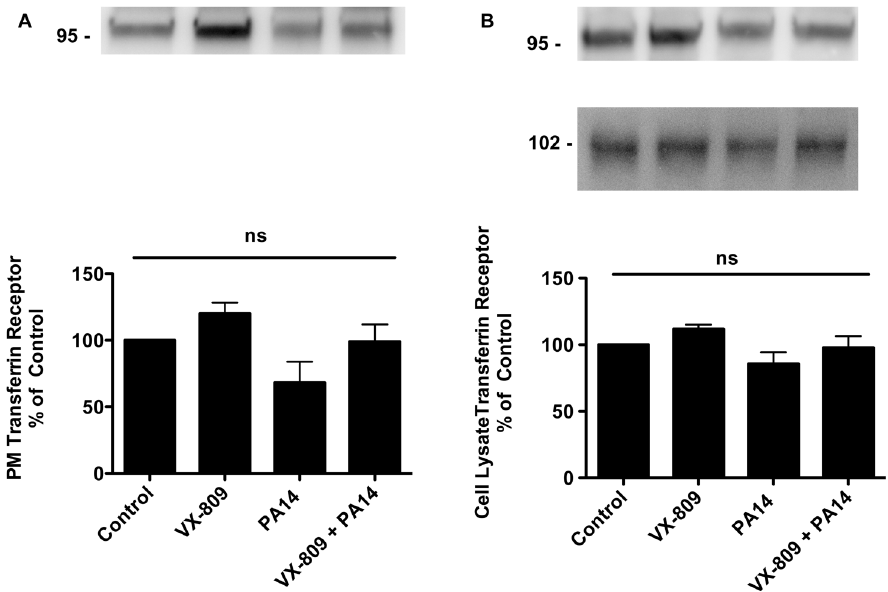
Fig 7. Analysis of plasma membrane transferrin receptor in the presence of VX-809 alone and in combination with P . aeruginosa . (A) Representative western blot of apical plasma membrane transferrin receptor (TfR) in CFBE cells treated with vehicle (Control), VX-809 (3 μ M), PA14 alone, or VX-809 (3 μ M) + PA14. ns, not significantly different. N = 3/treatment. (B) Top: Representative western blot of cell lysate TfR in CFBE cells treated with vehicle (Control), VX-809 (3 μ M), PA14 alone, or VX-809 (3 μ M) + PA14. Bottom: Representative western blot of cell lysate Na + -K + -ATPase in CFBE cells treated with vehicle (Control), VX-